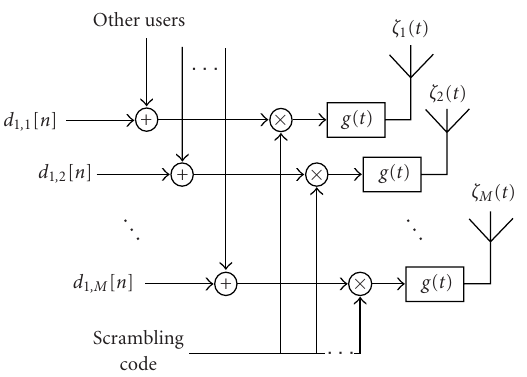
Figure 1: Baseband model of transmitter with M CPICHs trans- mitted on M